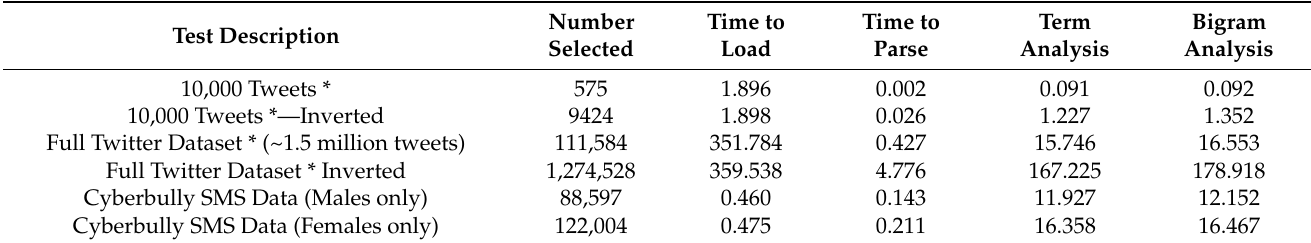
Table 1. Run time results (in seconds) on different size input data sets.